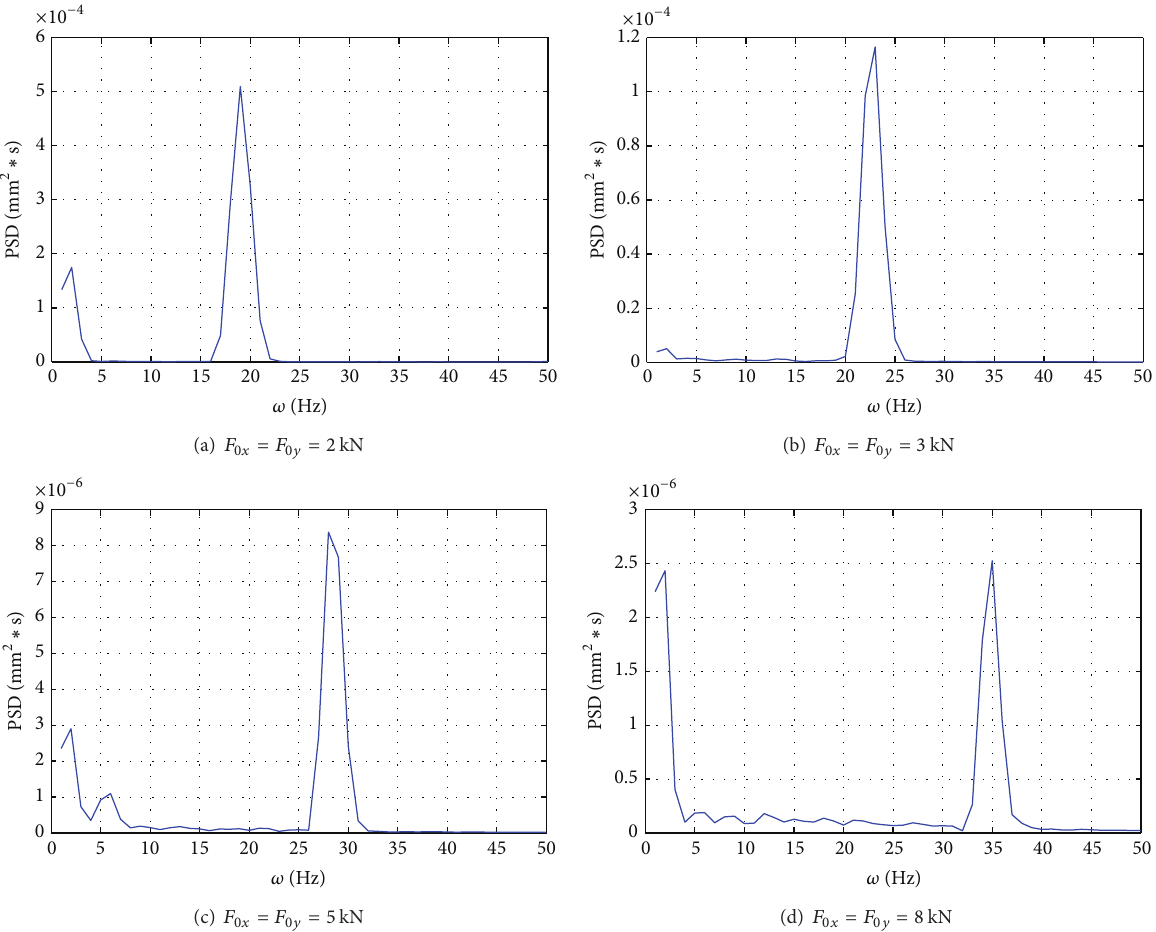
Figure 9: The displacement power spectral density curve of the C1 point for square Heytex membrane with different grades of